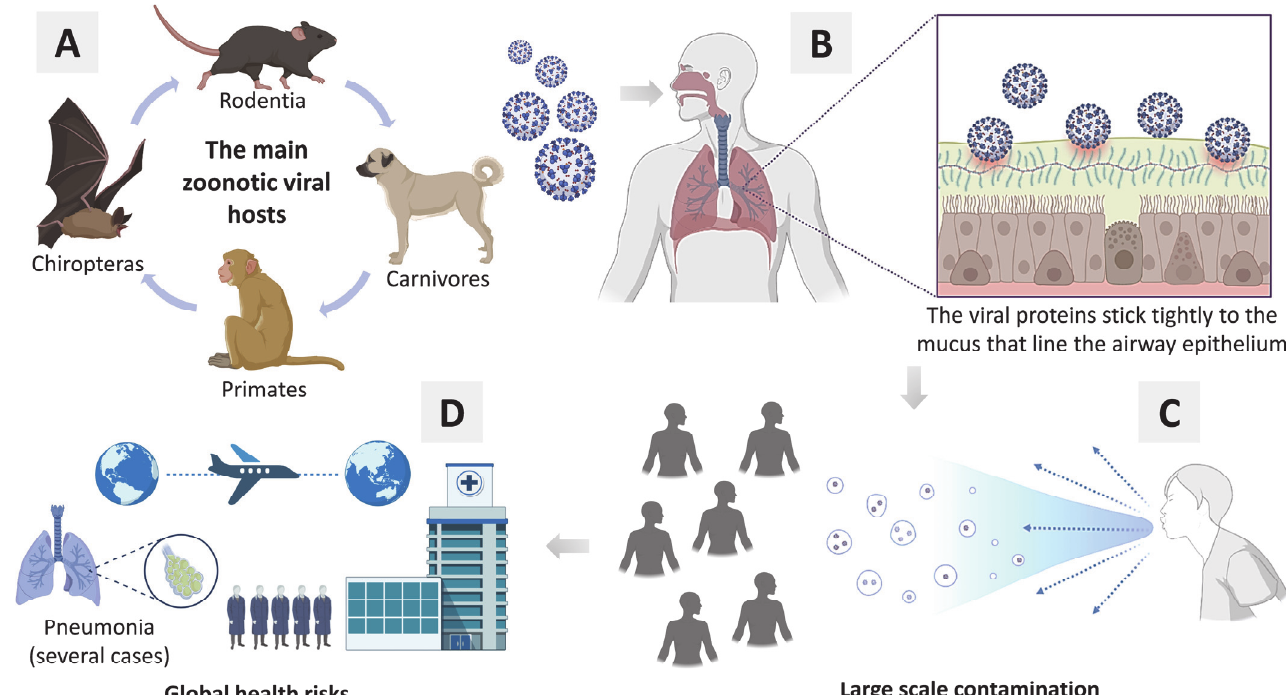
Figure 1. ( A ) The main animals (primary hosts) responsible for zoonotic viral transmission; ( B ) Basic general mechanism about viral infection in human cells; ( C ) Contamination of several people in society; ( D ) Global health risks (e.g., pandemic, hospital overcrowding, several cases of pneumonia, thousand deaths).